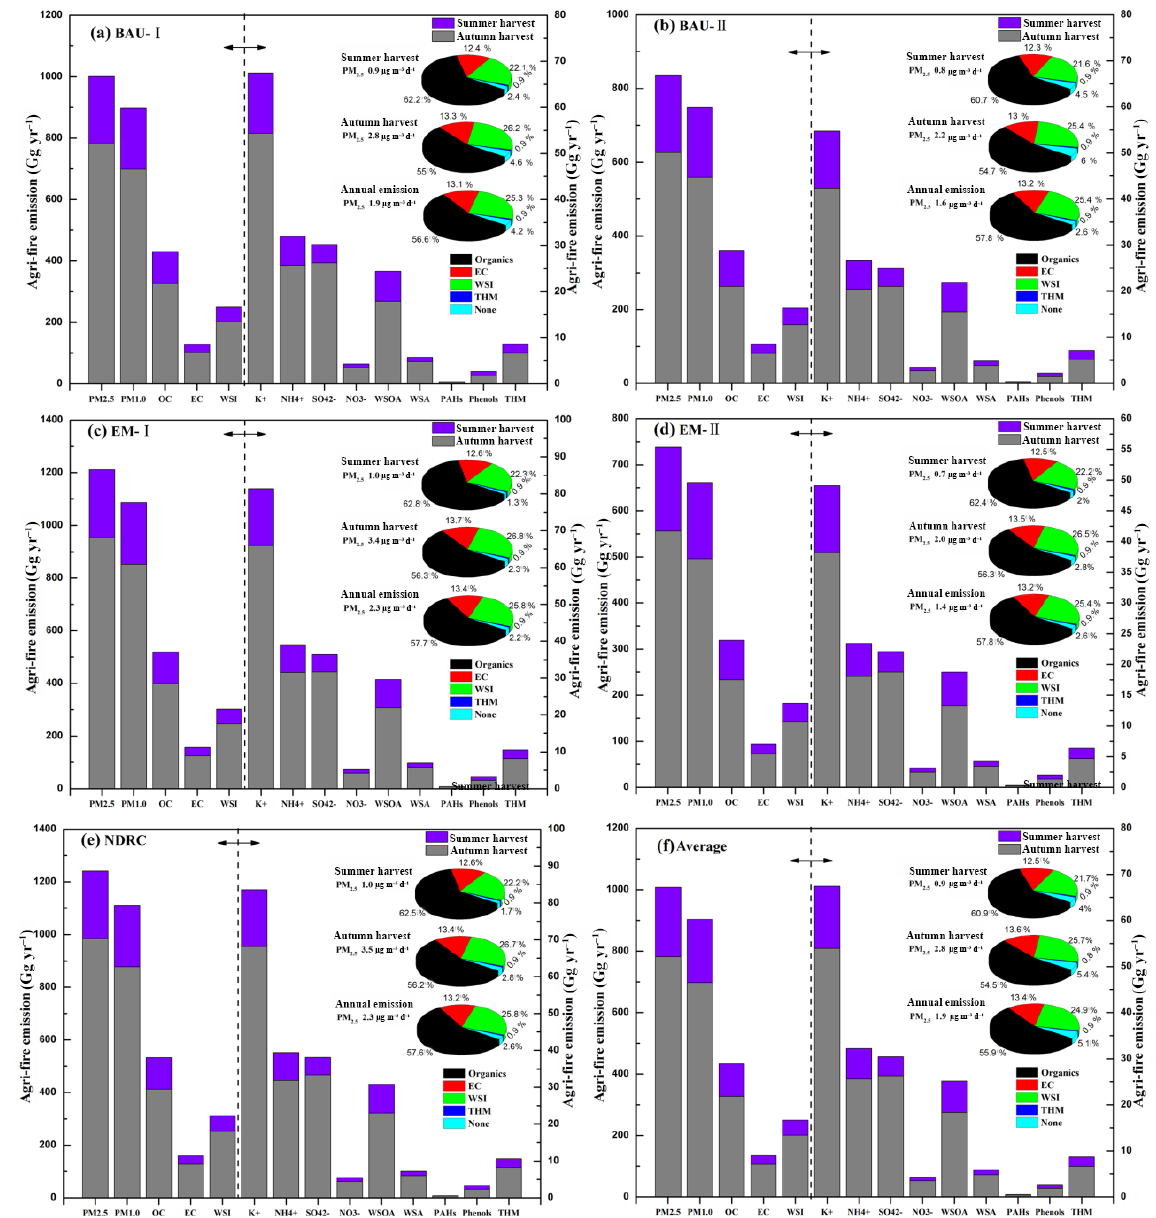
Figure 8. Nationwide PM 2 . 5 emissions and flux concentrations based on different burning versions. The inset pie graphs are chemical compositions of integrated PM 2 . 5 from five major agricultural residue